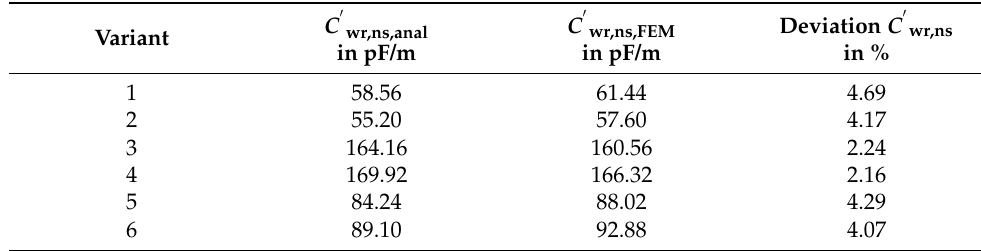
Table 2. Comparison of the length-related slot portions of the winding-to-rotor capacitances calcu- lated analytically with the FEM results.